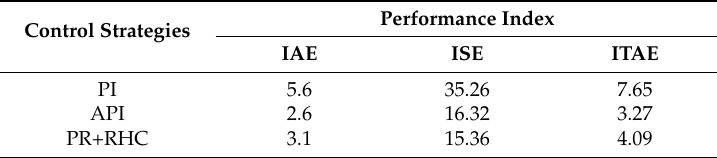
Table 9. Performance evaluation of the designed control strategies for I d .